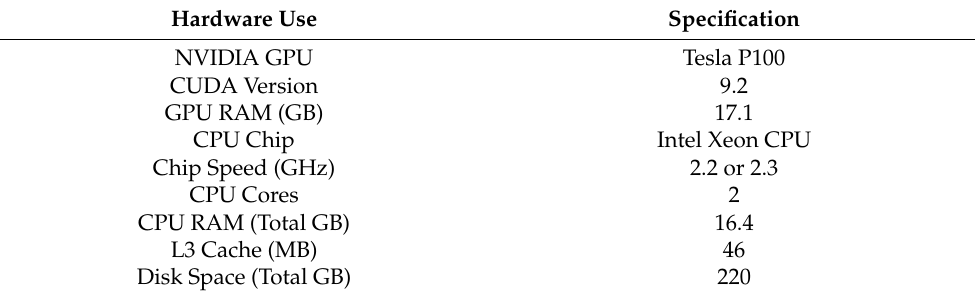
Table 7. Hardware specification.